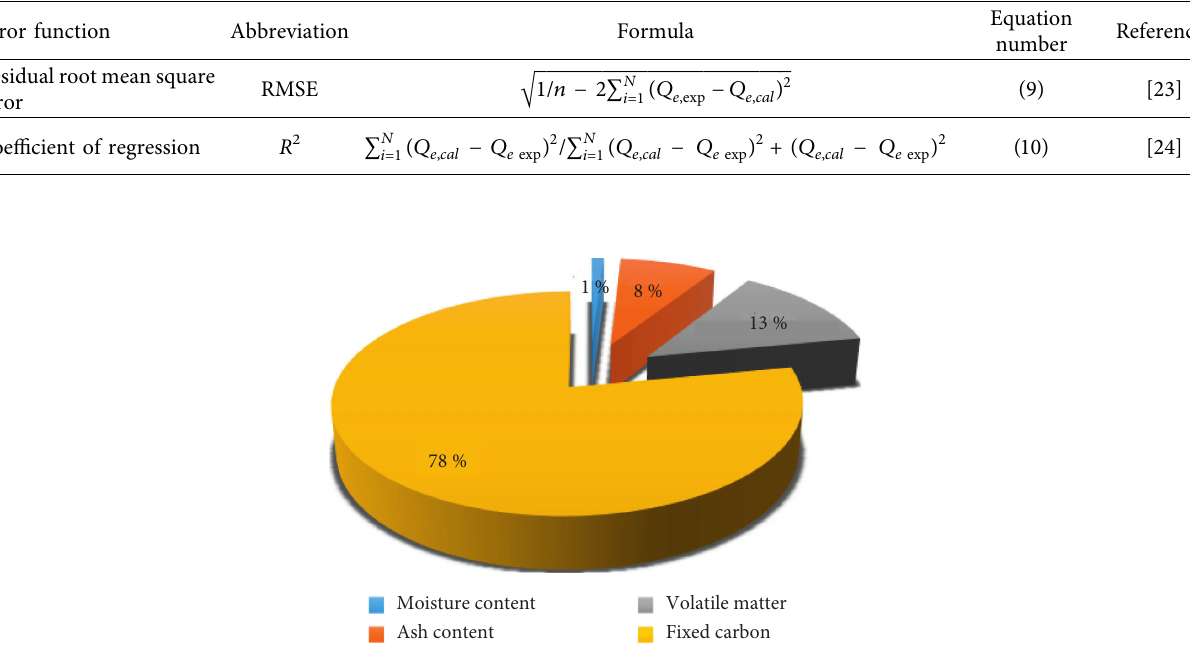
Table 1: Error functions and their equations.